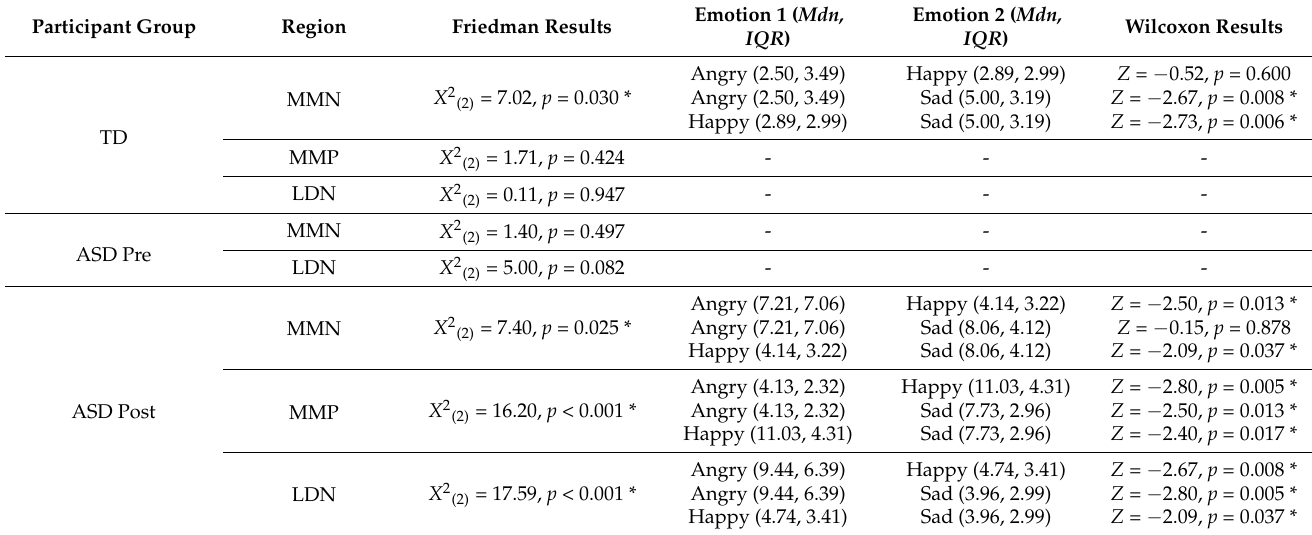
Table 3. Friedman analyses results (magnitude only) for all participant groups (TD, ASD pre-intervention, and ASD post-intervention) at each mismatch window. Additional information including median values, interquartile ranges, and individual Wilcoxon signed-ranks pair-wise comparison results are reported for significant main effects. * denotes emotion differences at a significance level of p ≤